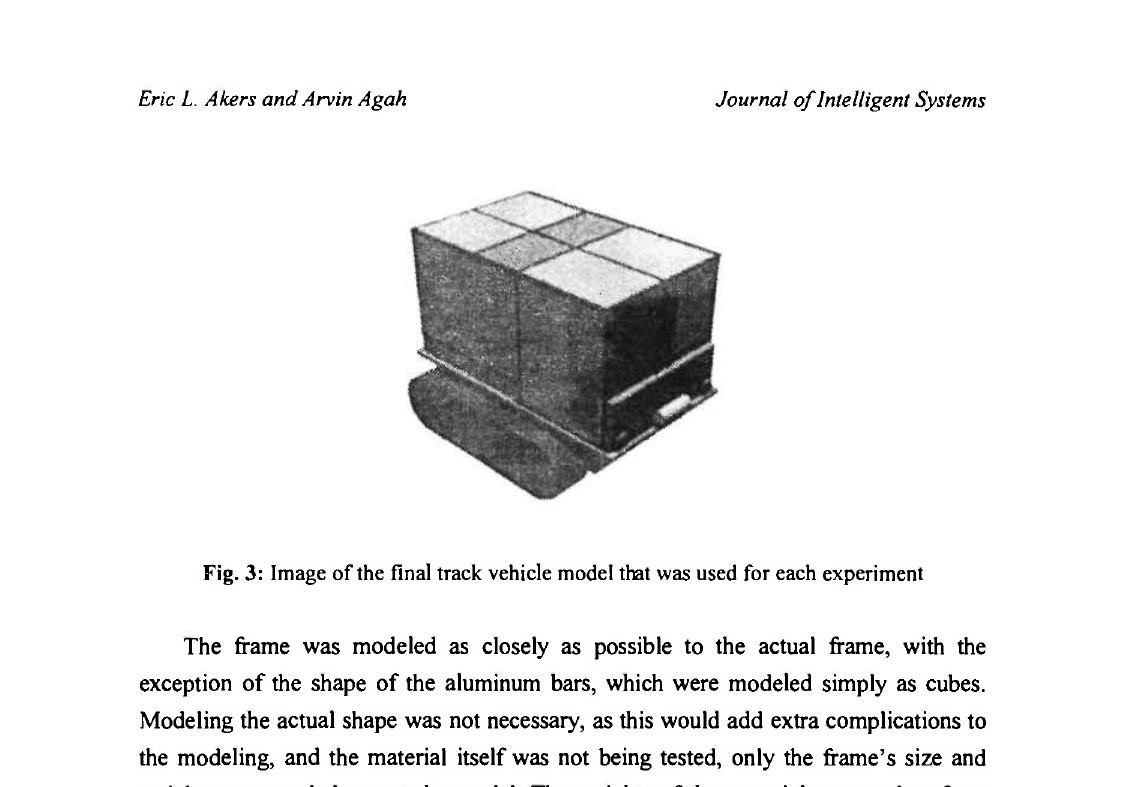
The frame was modeled as closely as possible to the actual frame, with the exception of the shape of the aluminum bars, which were modeled simply as